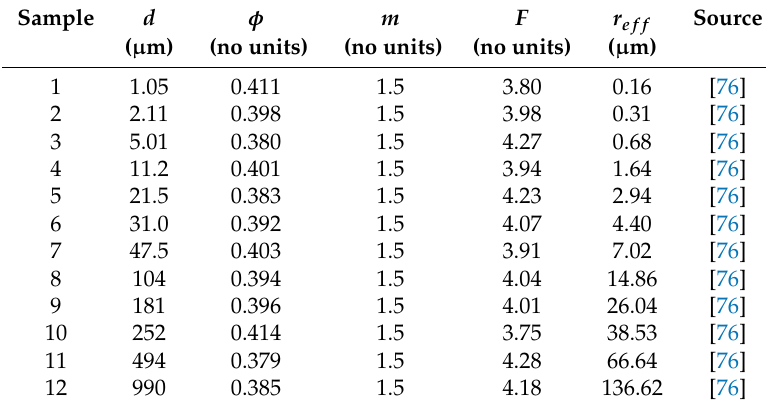
Table 3. Properties for a set of glass bead packs reported in [76]. Symbols of d ( µ m), φ (no units), m (no units), F (no units), and r ef f ( µ m) stand for the grain diameter, porosity, cementation exponent, formation factor, and effective pore radius of the glass bead samples,